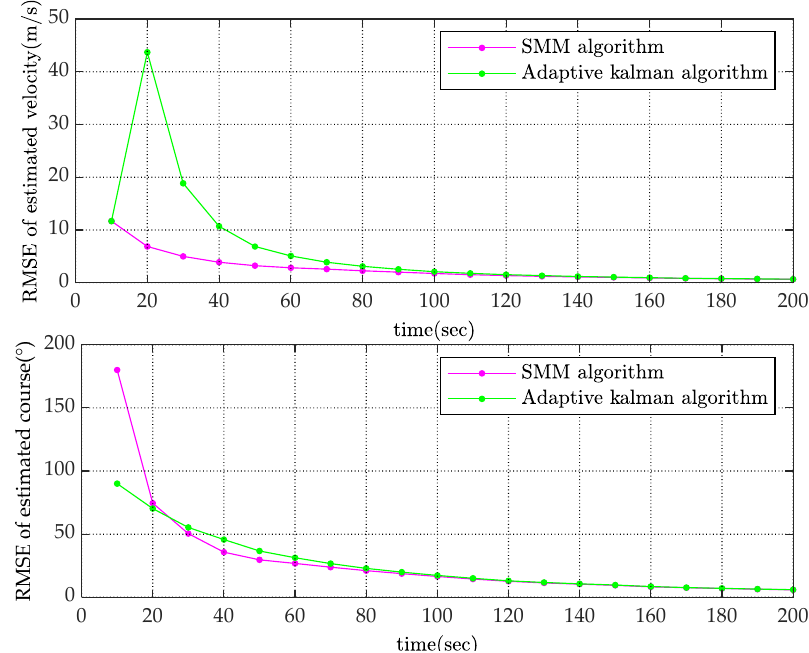
Figure 5. Comparison of RMSE for estimated velocity and course.